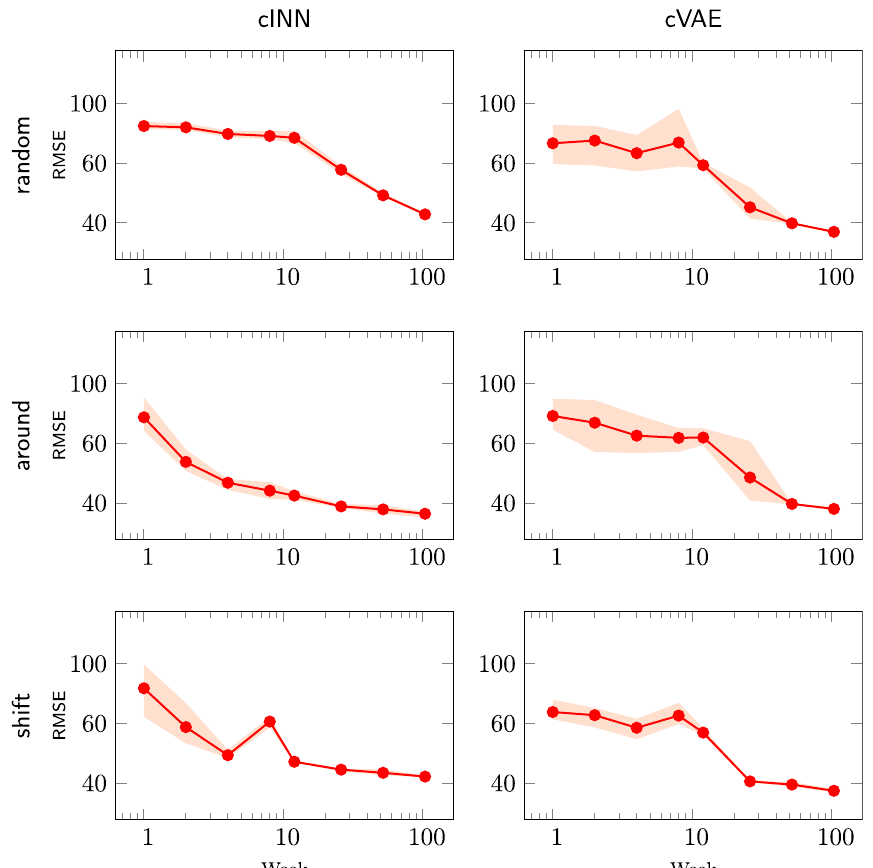
Fig. 9 The mean RMSE and the band comprising the minimum and maximum RMSE for the three seed noise sampling strategies (random, around, and shift), the two generative models (cINN and cVAE), and different amounts of available target data ( MT_124 ). The used forecasting model is the FCN and the LSFE is applied with the combined data combination strategy for the cINN and the fine-tune data combination strategy